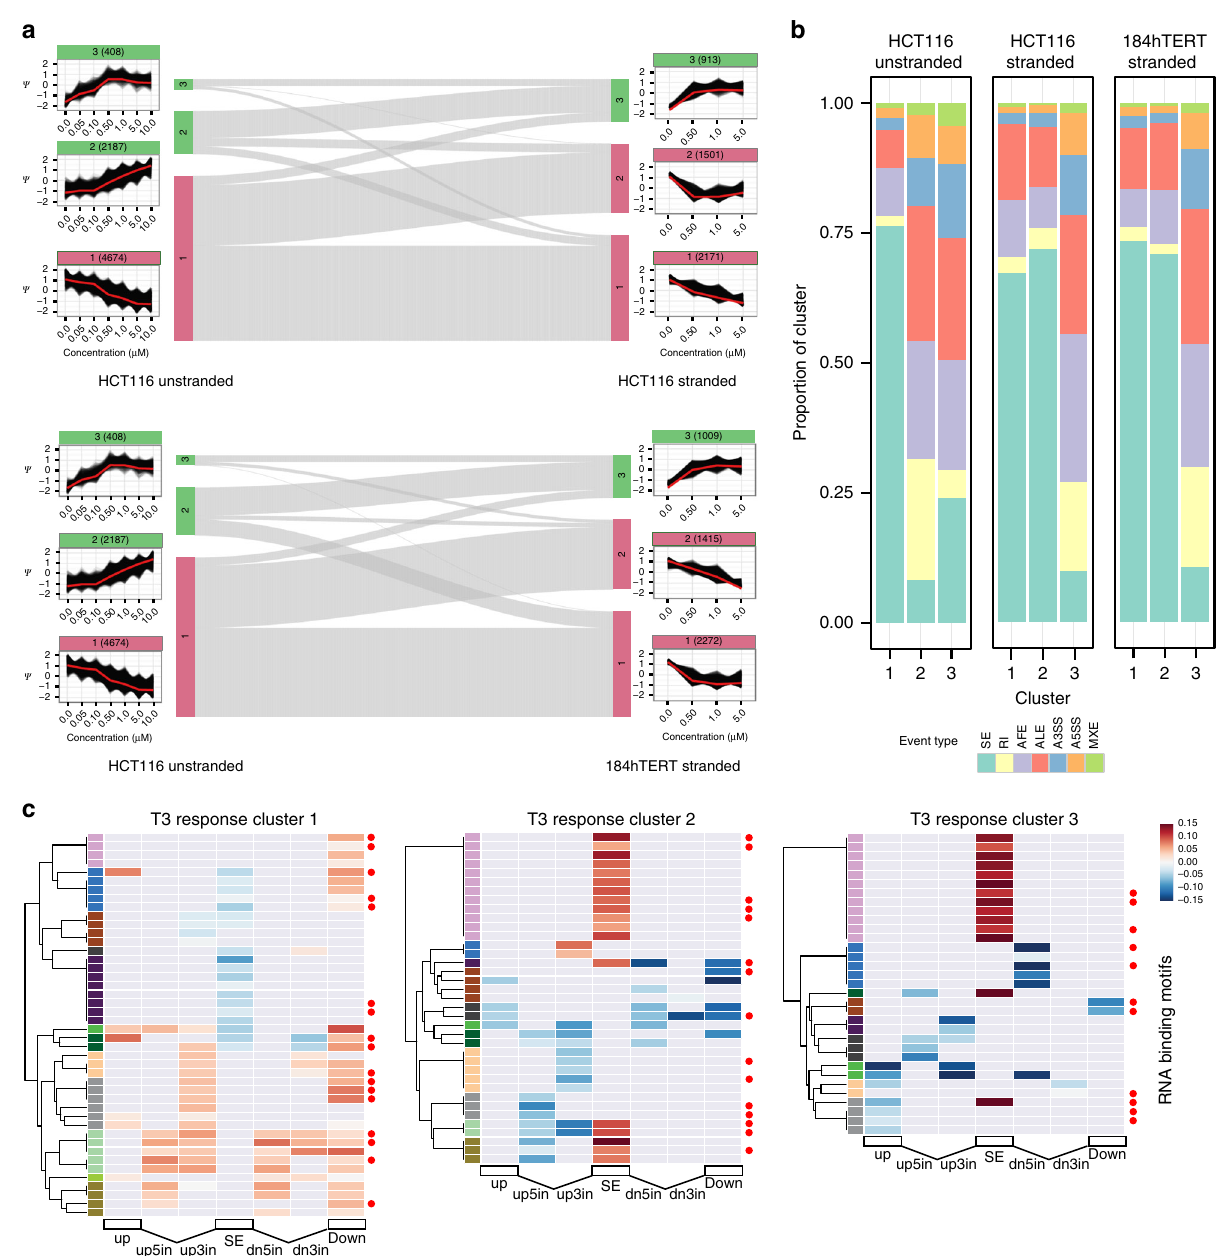
Fig. 2 CLKi responsive AS gene clusters analyzed by event type. a PSI cluster pro fi les and relationships between HCT116 and 184hTERT cell types. The schematic is organized as a sankey diagram in the center, showing the relationships between AS events within clusters ( vertical bars , with cluster number), pairwise in each of the three data sets. Events associated with increasing PSI have a green colored bar / title , those with decreasing PSI a red colored bar . The gray lines show the relationship between common members. The PSI vs. T3 dose response plots are shown aligned to the cluster they represent. Black lines represent AS event PSI pro fi les. The vertical axis represents standardized PSI score. The horizontal axis represents T3 concentration ( µ M). Red lines are cluster eigen-events. The number of events in each cluster is shown in parentheses in the cluster label, which is colored green for clusters that increase in PSI with increasing T3 concentration and red for clusters that decrease with T3. b Cluster event type proportions. The proportion of MISO event types in each cluster is shown as a stacked bar plot . The event key is shown below. c Heatmap showing RBP motifs with a signi fi cant density difference in PSI cluster 1 (monotonic PSI decrease cluster), 2 and 3 (PSI increase clusters) SE sequences compared to other PSI clusters for HCT116 unstranded RNA-Seq Δ SE events. Only one motif per RBP family is shown, for full display with labels see Supplementary Figs. 21, 22, 23. Horizontal axis represents seven SE event sequence regions analyzed: up (upstream exon), up5in and up3in (5 ′ and 3 ′ sections of the upstream intron), SE, dn5in and dn3in (5 ′ and 3 ′ sections of the downstream intron), and dn (downstream exon). Cells with non-signi fi cant differences are colored gray . Colored cells represent a positive ( red ) or negative ( blue ) effect size. Color bars on the left of vertical axis represent a possible motif cluster assignment based on signi fi cance and effect size patterns. Red dots indicate splicing factors associated with CLK family